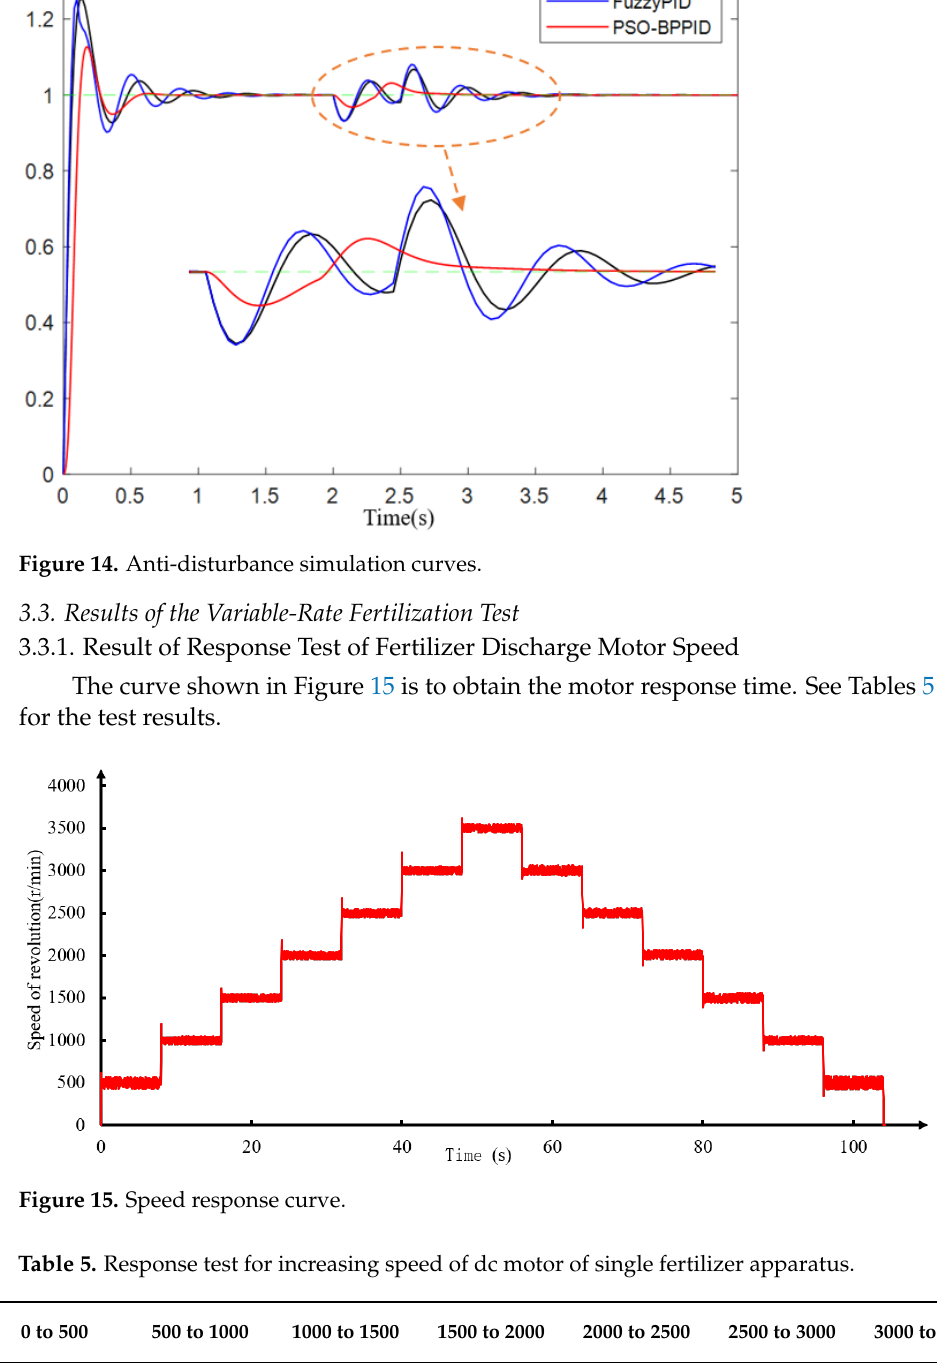
Table 4. Comparison of anti-disturbance performance indexes.